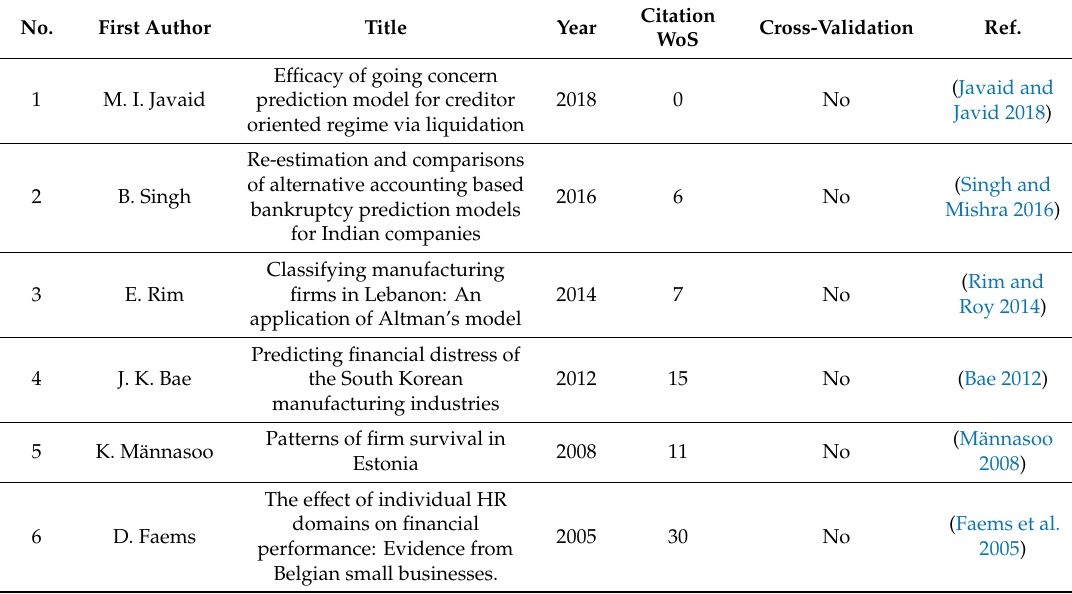
Table 9. Robustness check random sample